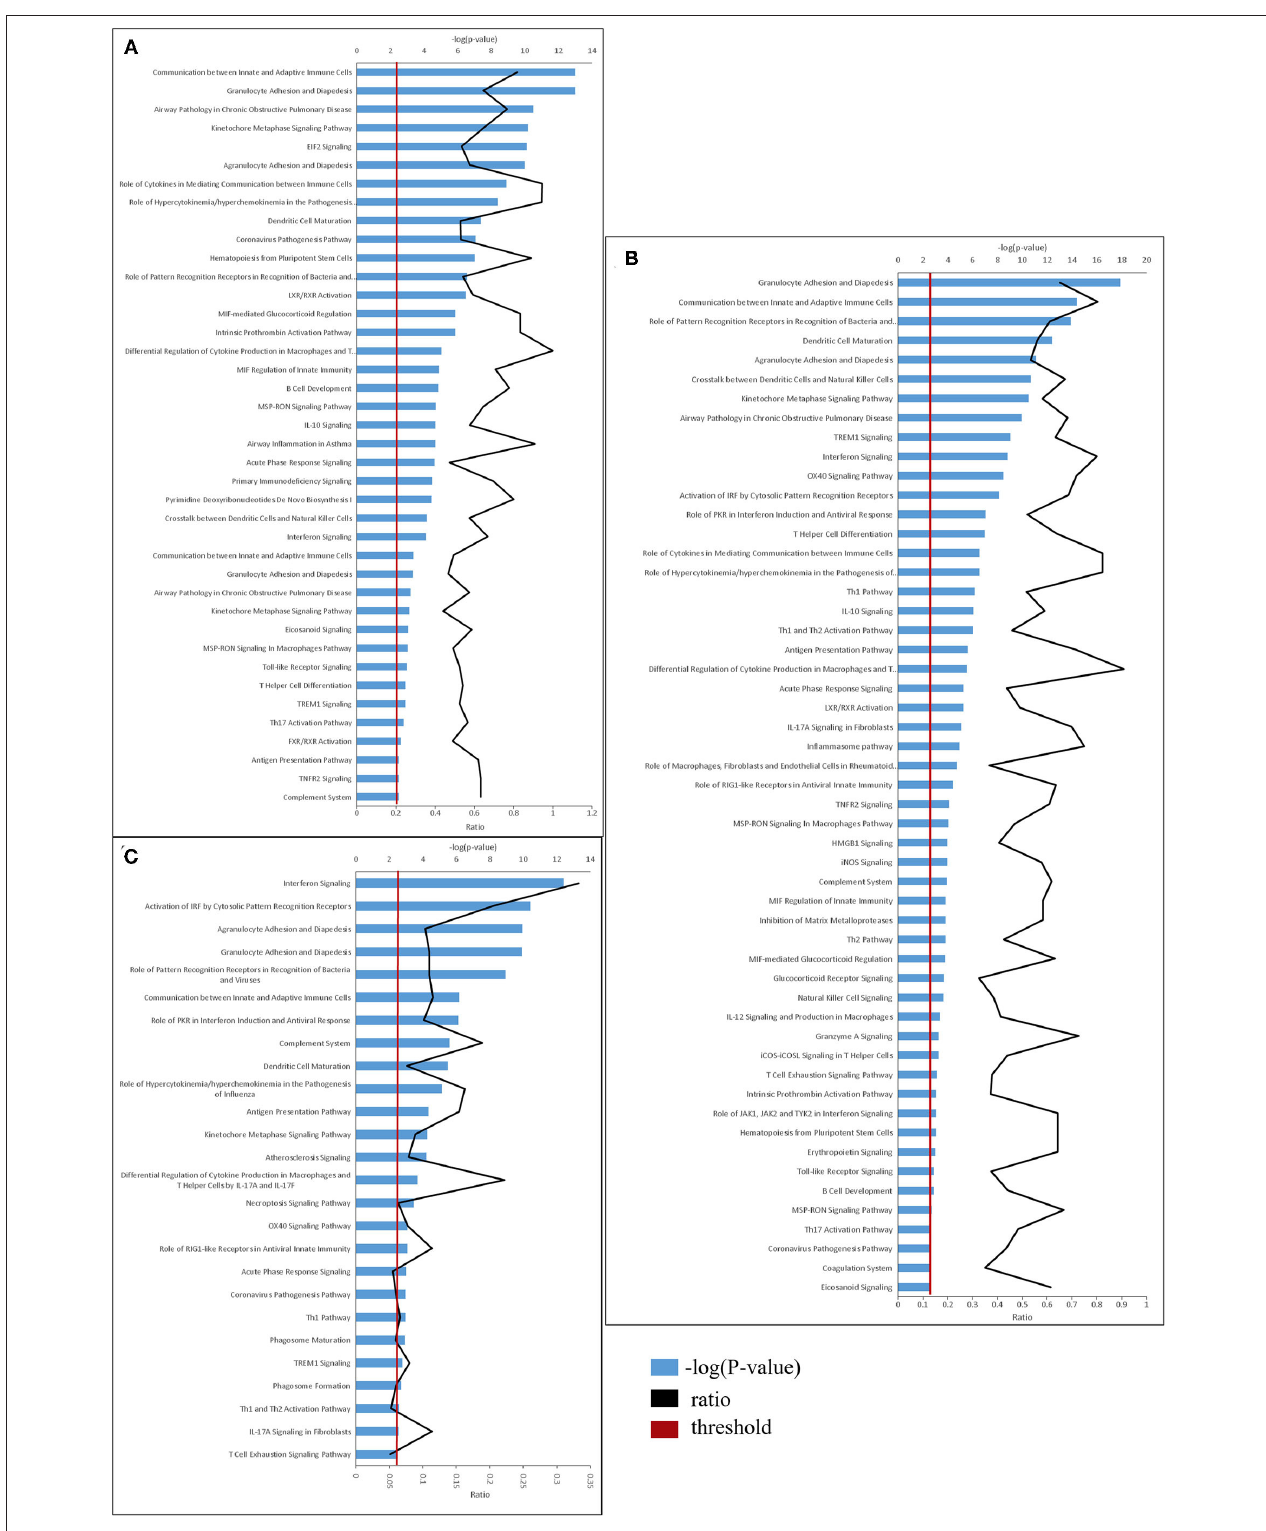
FIGURE 3 | Top canonical pathways derived from Ingenuity pathway analysis. The canonical pathways are analyzed with both up and down-regulated genes ( p ≤ 0.01) and ranked ac-cording to their –log ( P- value) (blue bars). “Threshold” (red line) indicates the minimum significance level (scored as –log [ P -value] set here at 2.5). “Ratio” (black curve) indicates the number of molecules from the data set that map to the pathway listed divided by the total number of molecules that map to the canonical pathway from within the IPA database. (A) naïve vs. LDR. (B) naïve vs. LDR-SC2. (C) naïve vs. SC2.